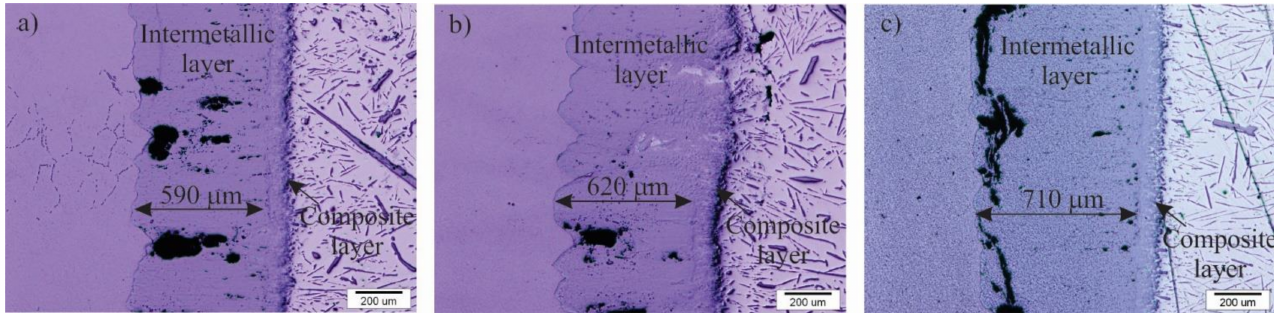
Figure 2. Micrographs of the interface between W600 ( a ), HTCS-130 ( b ), and UTOPMO1 ( c ) tool steel and Al99.7 aluminum alloy at 700 ◦